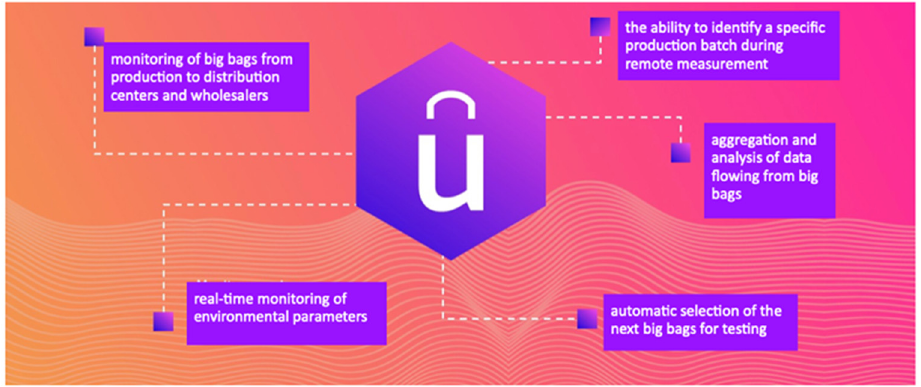
Figure 1. Functional structure of the system.